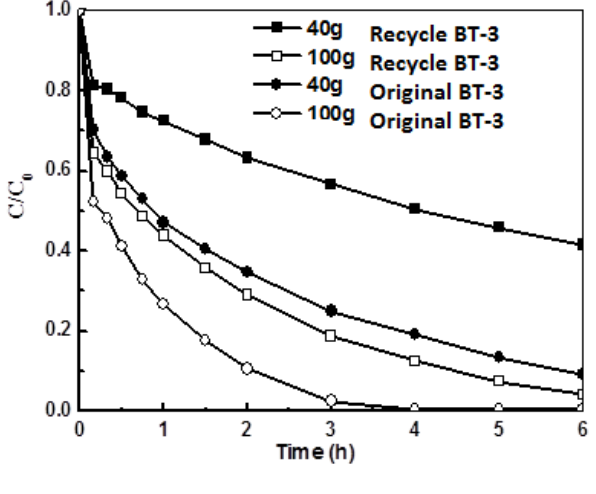
in binary system. 4